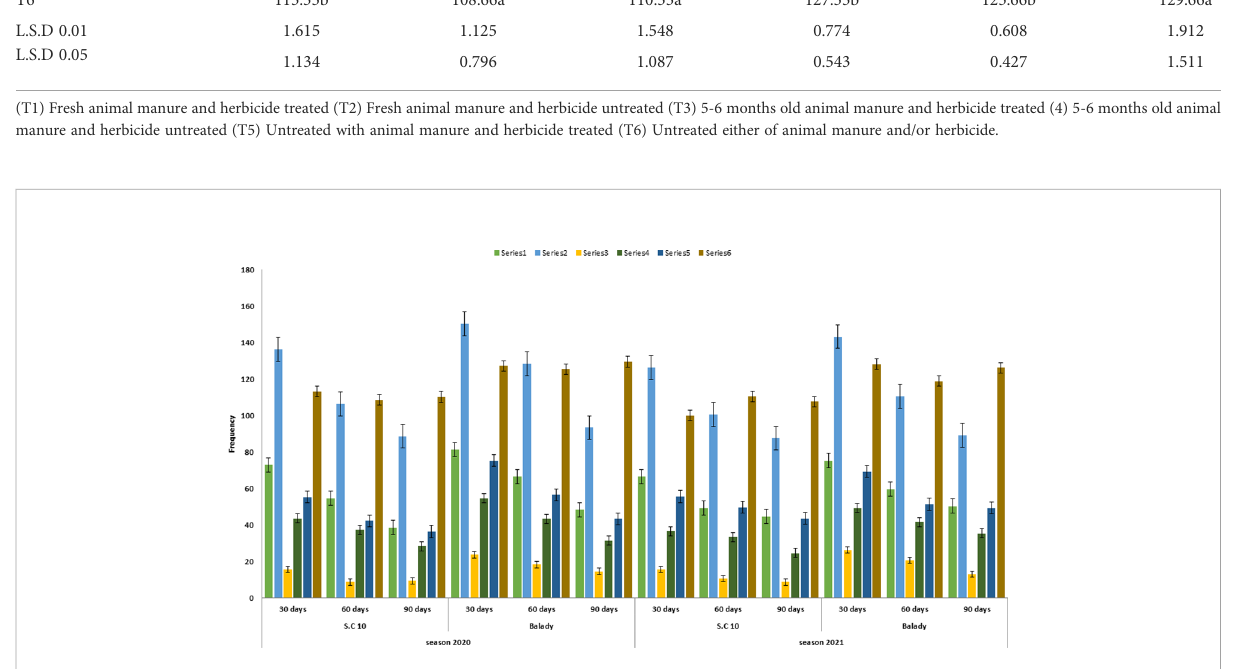
FIGURE 1 F. verticillioides frequency from soil under different soil treatments at different times after sowing during the 2020 and 2021 growing seasons. Treatment1= soil was treated with fresh animal manure and herbicide. Treatment 2= soil was treated with fresh animal manure and untreated with herbicide. Treatment 3= soil treated with 5-6 months old animal manure and herbicide. Treatment 4= soil was treated by 5-6 months old animal manure and untreated with herbicide. Treatment 5= soil was untreated with any animal manure and treated with herbicide. Treatment 6=soil was Untreated either of any animal manure and/or herbicide.